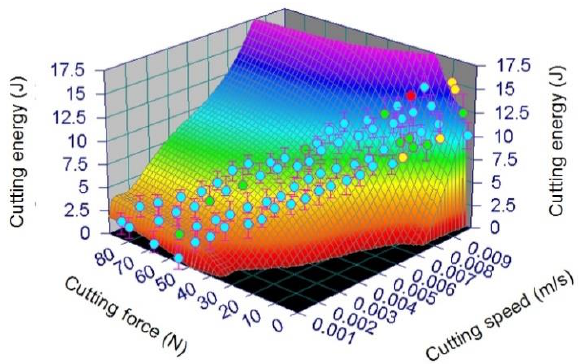
Figure 18. The surface generated by equation no. 145 for peeled apples.